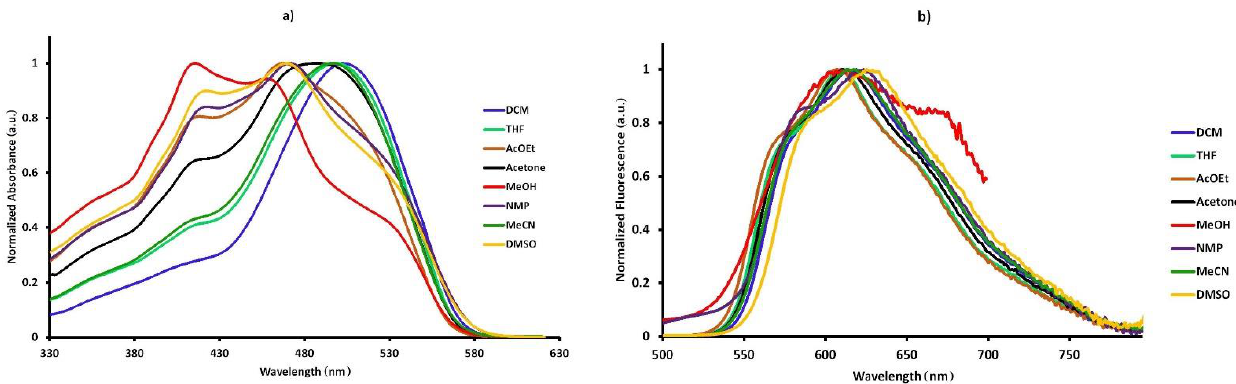
Figure 6. Normalized absorption ( a ) and fluorescence ( b ) spectra of 1-(4-ethoxy)phenylazonaphthalen-2-ole difluoroborane ( 6 ) in solvents of different polarity.